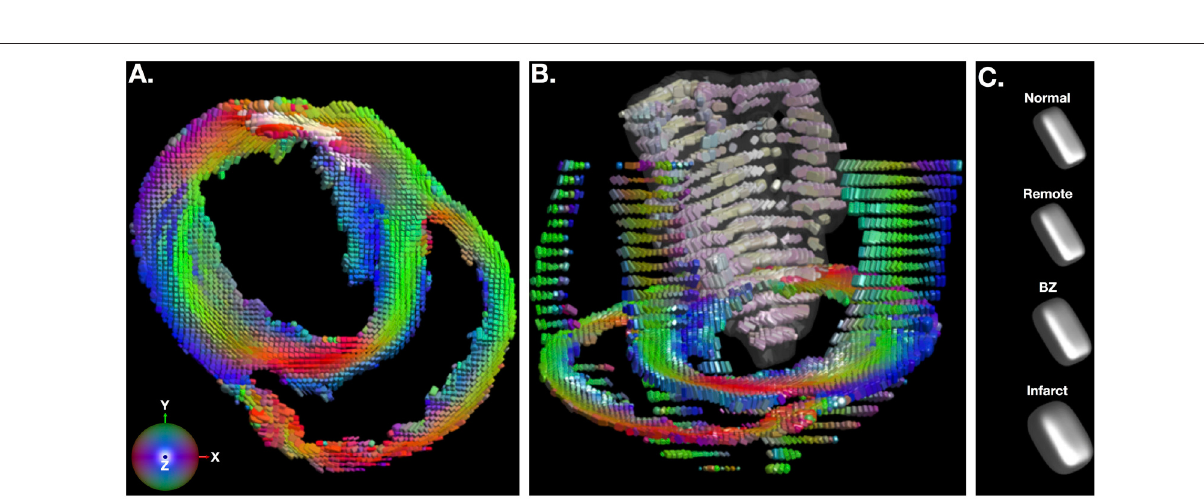
Frontiers in Physiology | www.frontiersin.org